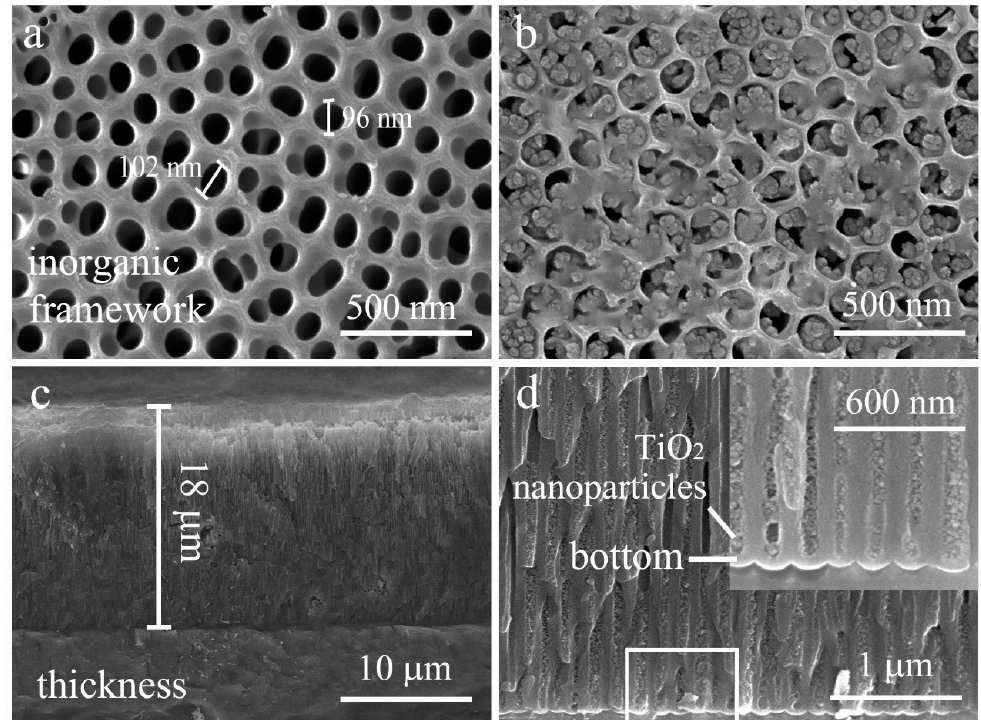
Figure 3. SEM images of ( a ) the AAO obtained via anodizing the 6061 Al under a constant voltage of 50 V in 5 wt% OA electrolyte system, ( b ) the coating surface with the nanoporous framework, ( c ) the coating cross-section with a thickness of 18 µ m, and ( d ) the bottom full filled with nanoparticle-induced superhydrophobic nanofiller.